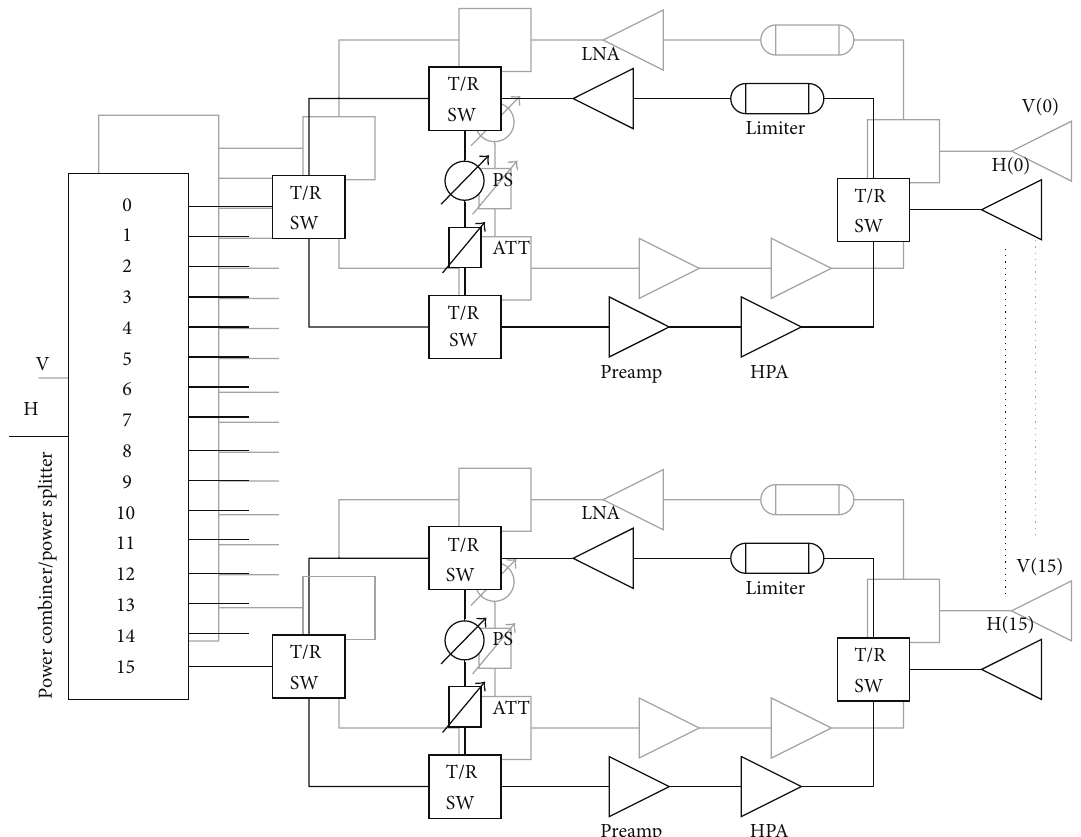
Figure 3: An example of CPAD front-end system architecture for planar array